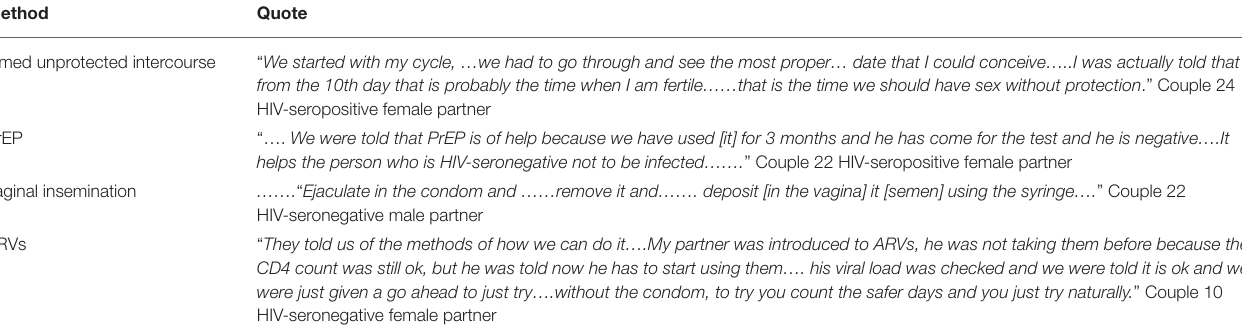
TABLE 2 | Excerpts describing couples’ knowledge of safer conception methods.